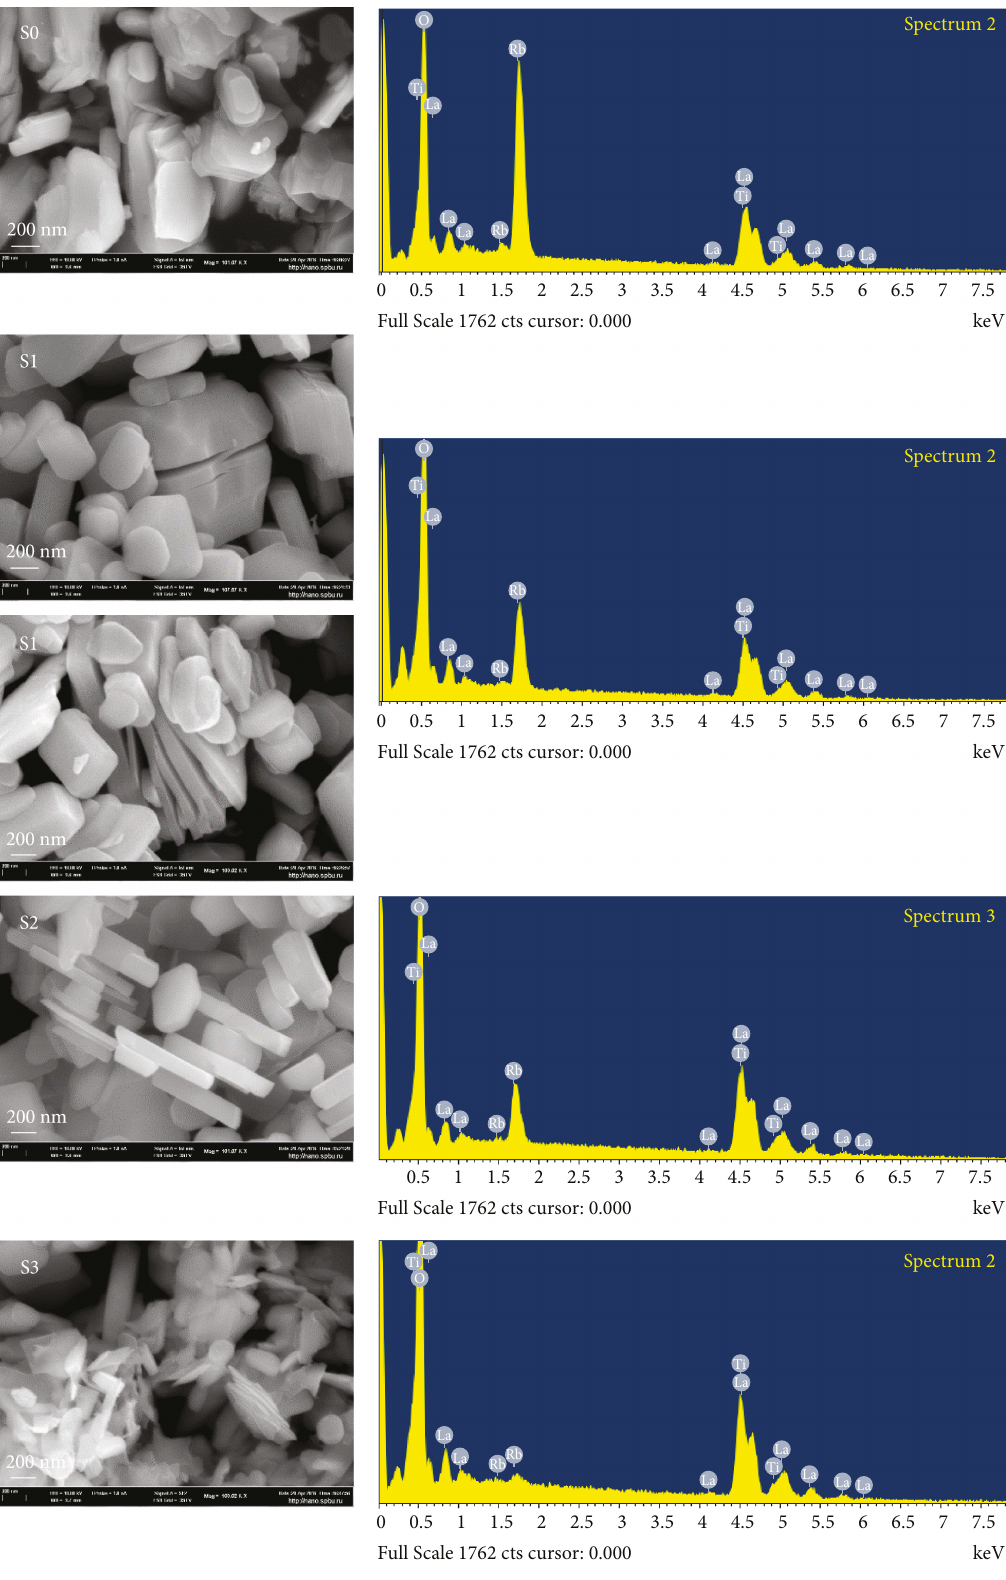
Figure 4: SEM images and X-ray microanalysis of obtained samples S0, S1, S2, and